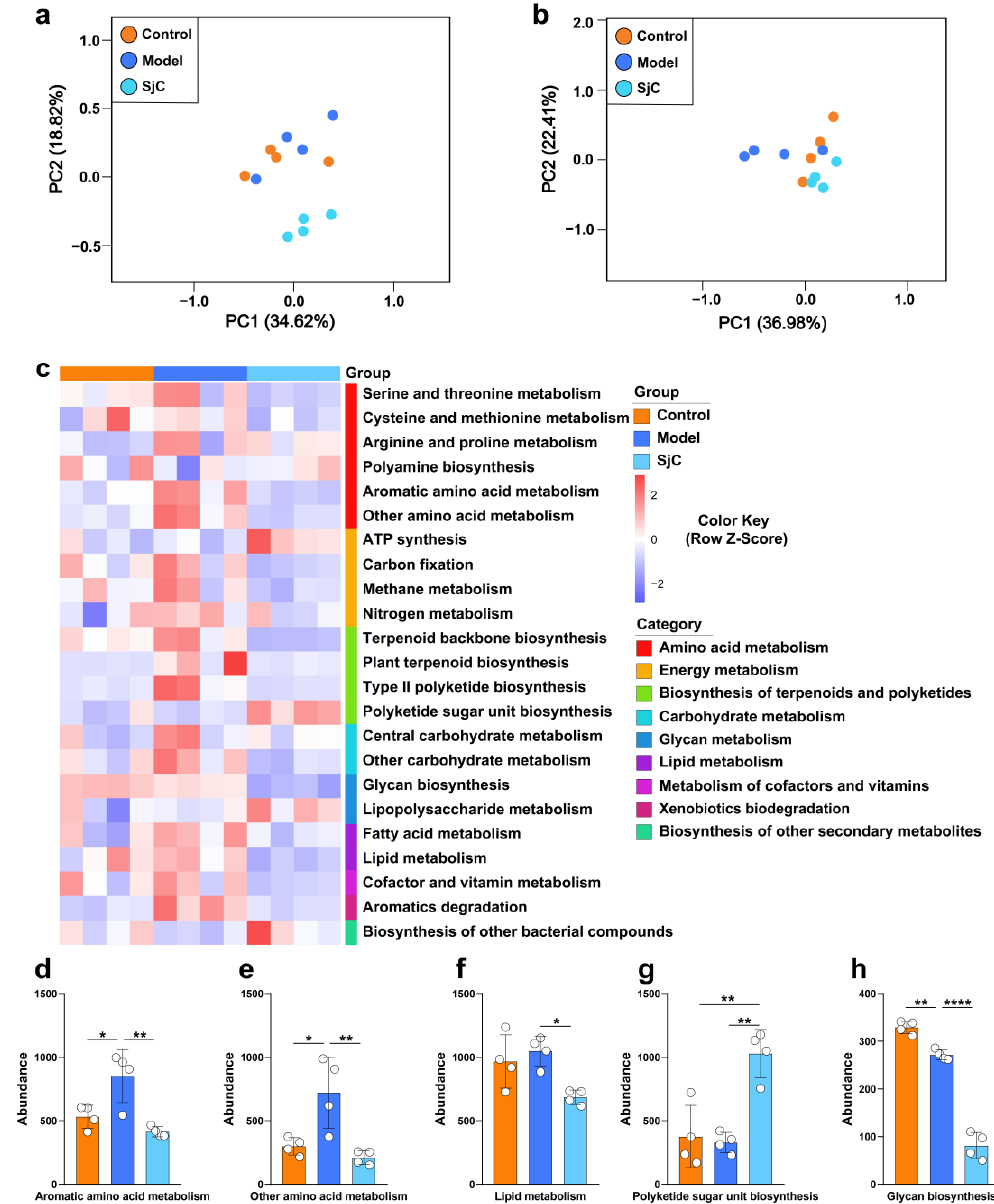
Figure 4. Metagenomic sequencing analysis revealed the effects of SjC supplementation on the abundance of functional genes and metabolic pathways of gut microbiota. The PCA analysis of the ( a ) functional genes and ( b ) metabolic pathways. ( c ) Metabolic pathways with significant differences ( p < 0.05) among the groups. KEGG pathways were colored according to their functional categories. Relative abundance of ( d ) aromatic amino acid metabolism, ( e ) other amino acid metabolism, ( f ) lipid metabolism, ( g ) polyketide sugar unit biosynthesis, and ( h ) glycan biosynthesis. All data are expressed by mean ± SEM ( n = 4). One-way ANOVA and Tukey multiple comparison analysis were used to analyze the significance between multiple groups, * p < 0.05; ** p < 0.01; **** p < 0.0001.